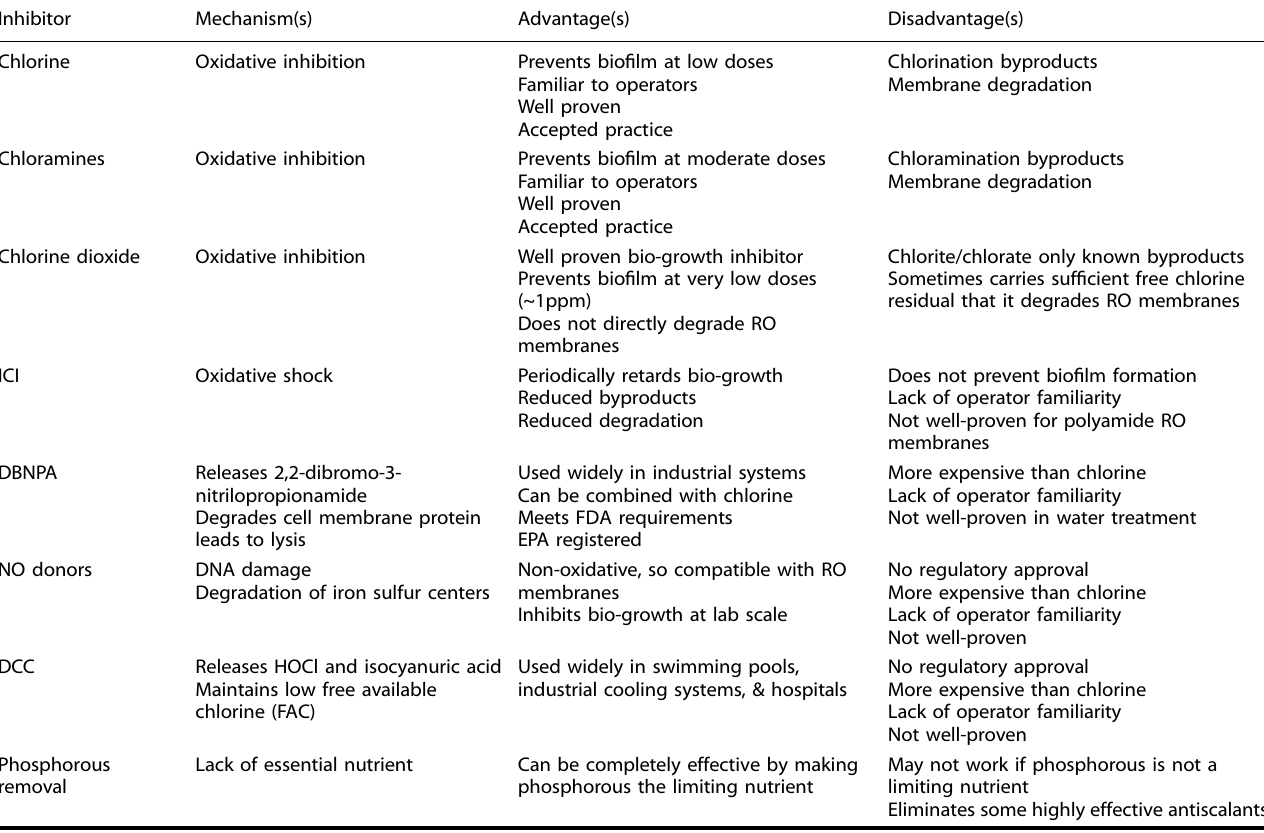
Table 6. Summary of bio-growth inhibitors, mechanisms, advantages and disadvantages. Inhibitor